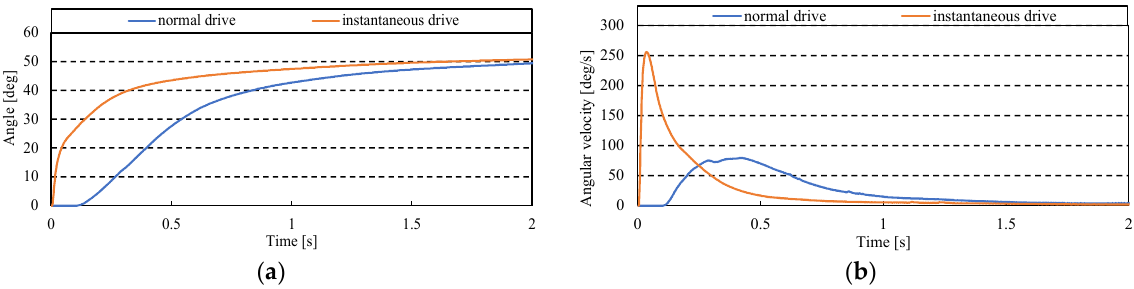
Figure 13. Measurement results of instantaneous drive and normal drive. ( a ) Results of angle. ( b ) Results of angular velocity.